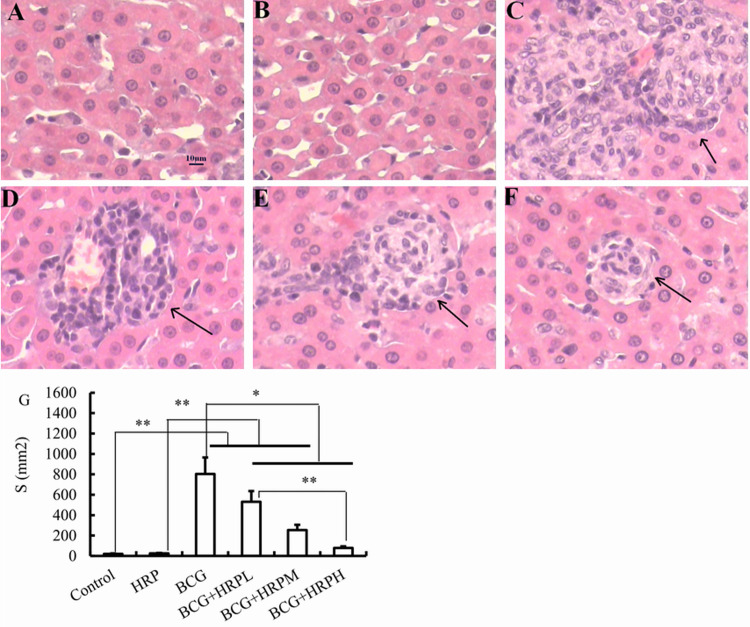
Effects of Hippophae rhamnoides L. (HRP) on histopathological or biochemical changes in rat liver.(A–F): Representative light microscope images of rat liver (hematoxylin staining; original magnification, ×400) for control (A); HRP (B); BCG group (C; arrows in figure point to granulomatous mass composed of inflammatory cells); BCG + HRPL (50 mg kg-1, D); BCG + HRPM (100 mg kg-1, E);and BCG + HRPH (200 mg kg-1, F). Representative light microscope images of inflammatory cell infiltrate area (S) in liver for each group is shown in G). Data are presented as means ± SD of n = 10 rats. Asterisks stars above bars indicate differences between groups.